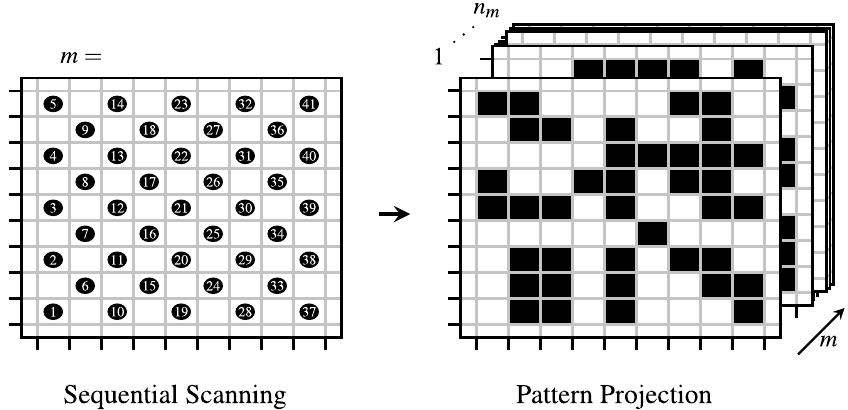
Figure 1. Experimental Transformation: The left image shows qualitatively the arrangement of measurement positions (black dots) in sequential laser scanning based photothermal SR reconstruction. Here the ROI is covered by n m measurements where each measurement only covers a small subsection of the total ROI. The right image shows the proposed new experimental technique of projecting a total of n m different pixel patterns, which individually already span the whole ROI. The black colored pixels are photothermally active (turned